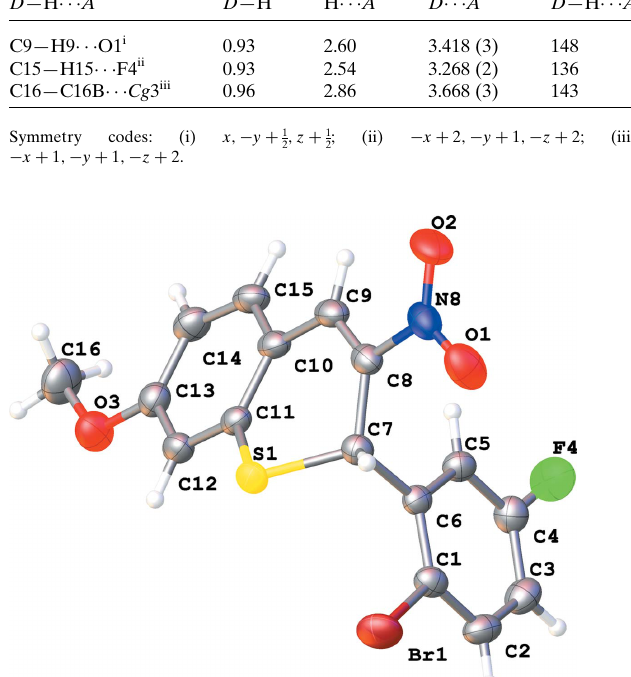
The molecular structure of 2-(2-bromo-5-fluorophenyl)-7-methoxy-3-